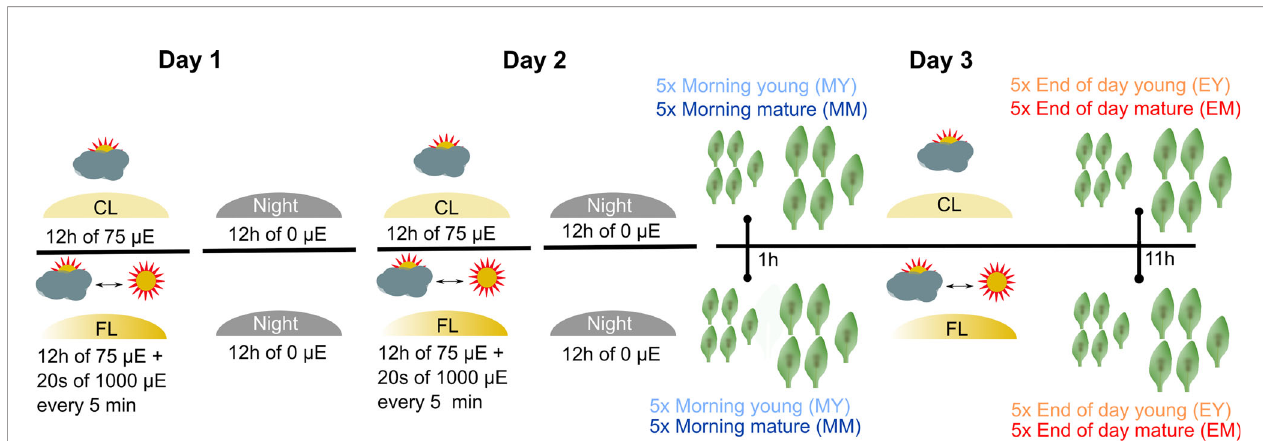
FIGURE 1 | Experimental design and pro fi ling AT proteome under FL. Six-week-old Arabidopsis plants grown at constant 75 µmol m -2 s -1 light intensity (CL) were split into a control group staying in CL and a group that was exposed to high intensity light pulses of 1,000 µmol m -2 s -1 for 20 seconds every 5 minutes under CL ( fl uctuating light, FL). On the third day of treatment, young and mature leaves were harvested 1 h after light on (morning young, MY; morning mature, MM) and 11 h after light on (end of day young, EY; end of day mature, EM), which we de fi ne as four “ samples ” . To obtain fi ve biological replicates of each sample, proteomes were extracted from leaves of fi ve independent